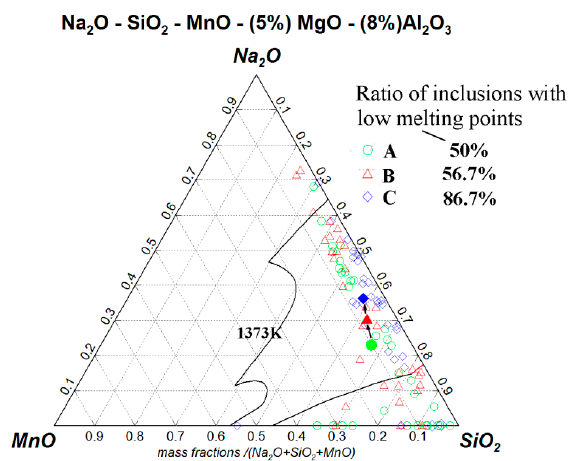
Figure 5. Typical morphologies and compositions of inclusions in wire rods from Heats A, B and C (wt%). ( a ) and ( b ) represent Heat A; ( c ) and ( d ) represent Heat B; ( e ) and ( f ) represent Heat C.